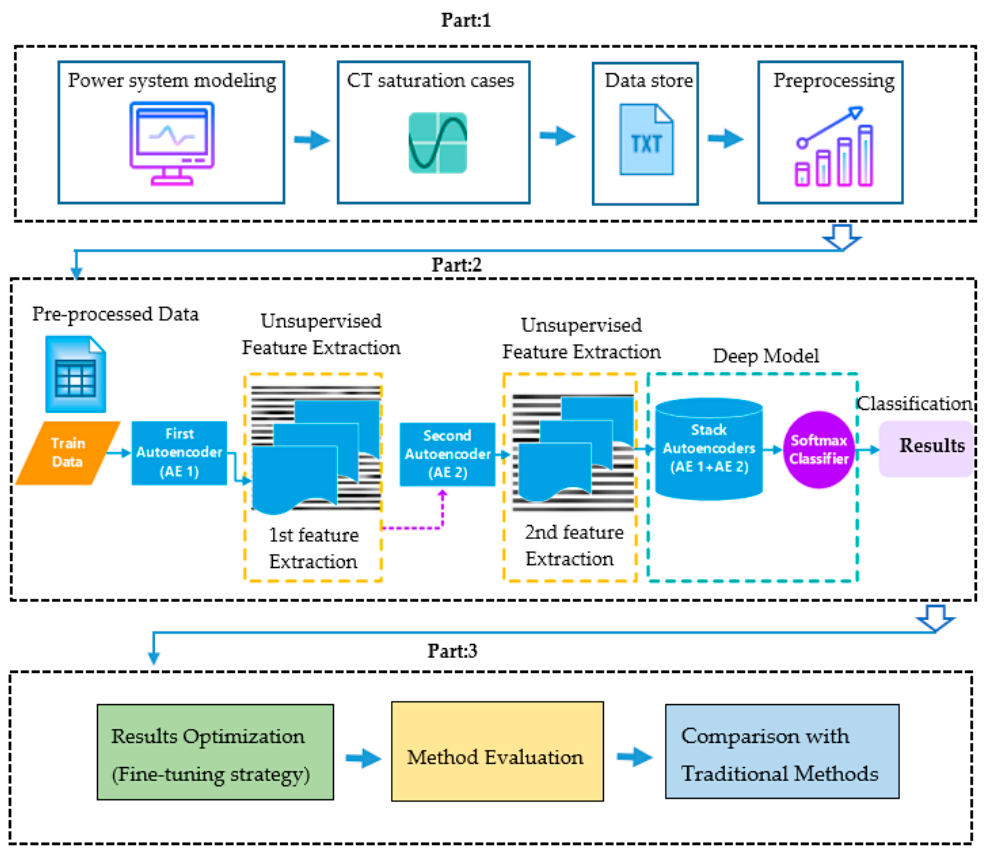
Figure 1. Framework of the proposed approach.